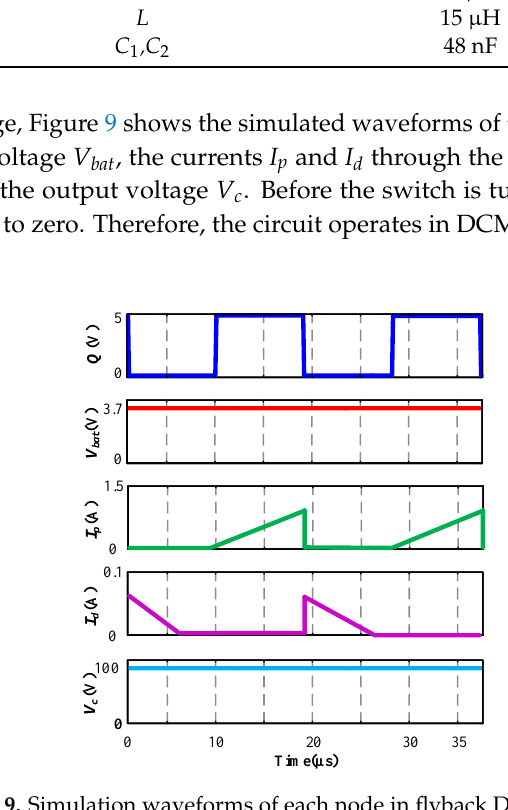
Figure 9. Simulation waveforms of each node in flyback DC/DC stage.